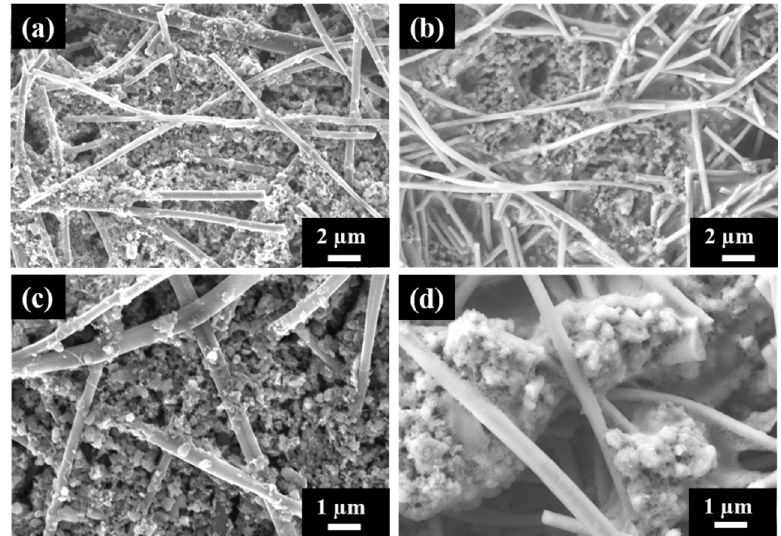
Figure 7. SEM images of S/DPAN/CNT composite cathode on the cPAN CNF current collector ( a , c ) fresh and ( b , d ) after 100 cycles of discharge.